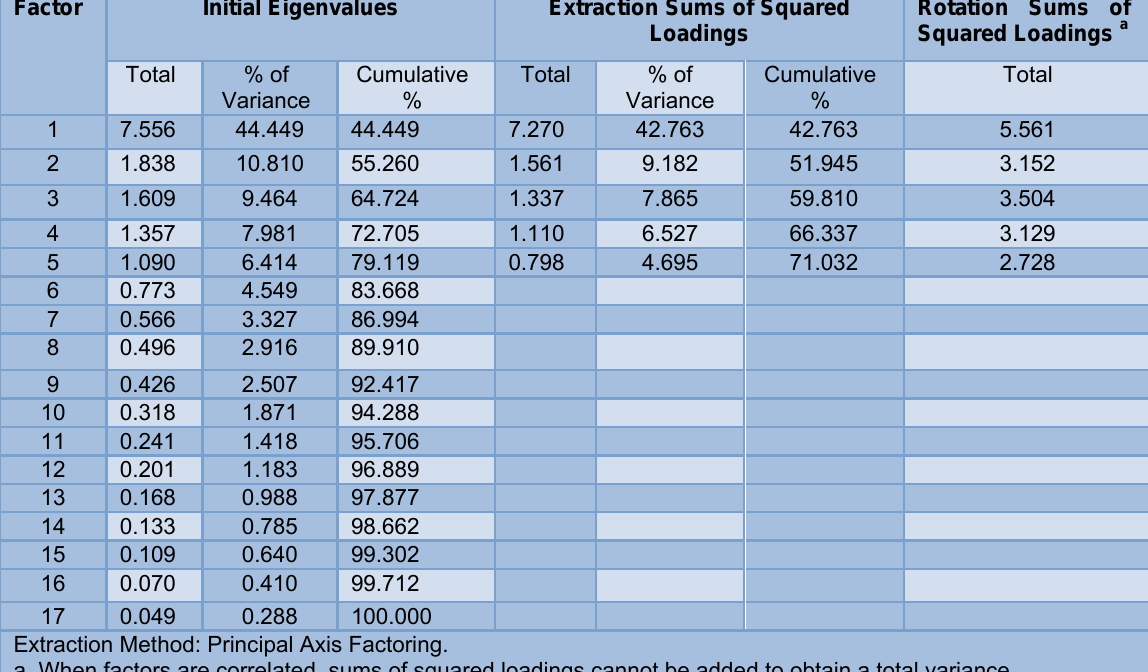
Table 2: Total Variance Explained for EL Decision Factor Initial Eigenvalues Extraction Sums of Squared